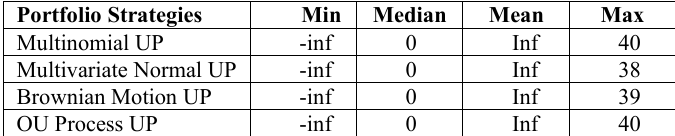
Table 5. Long term duration data analysis (16 years